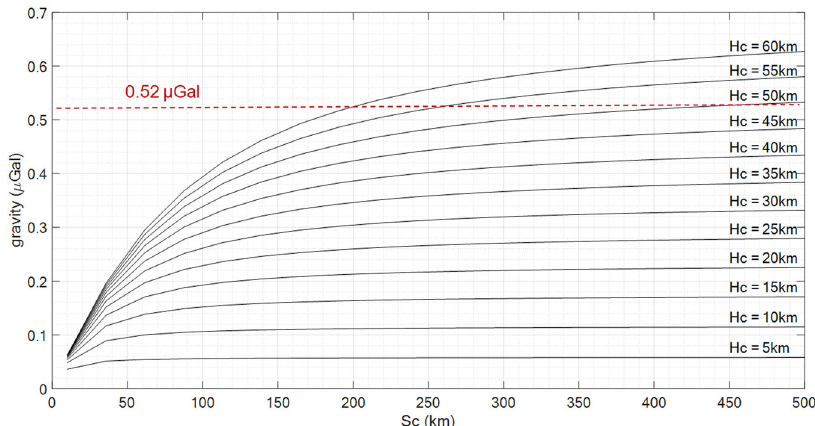
Fig. 10 Gravity forward modelling of dilatation strain. Gravity effect of 0.1 μ strain shortening in a prism with different vertical (Hc) and horizontal (Sc)